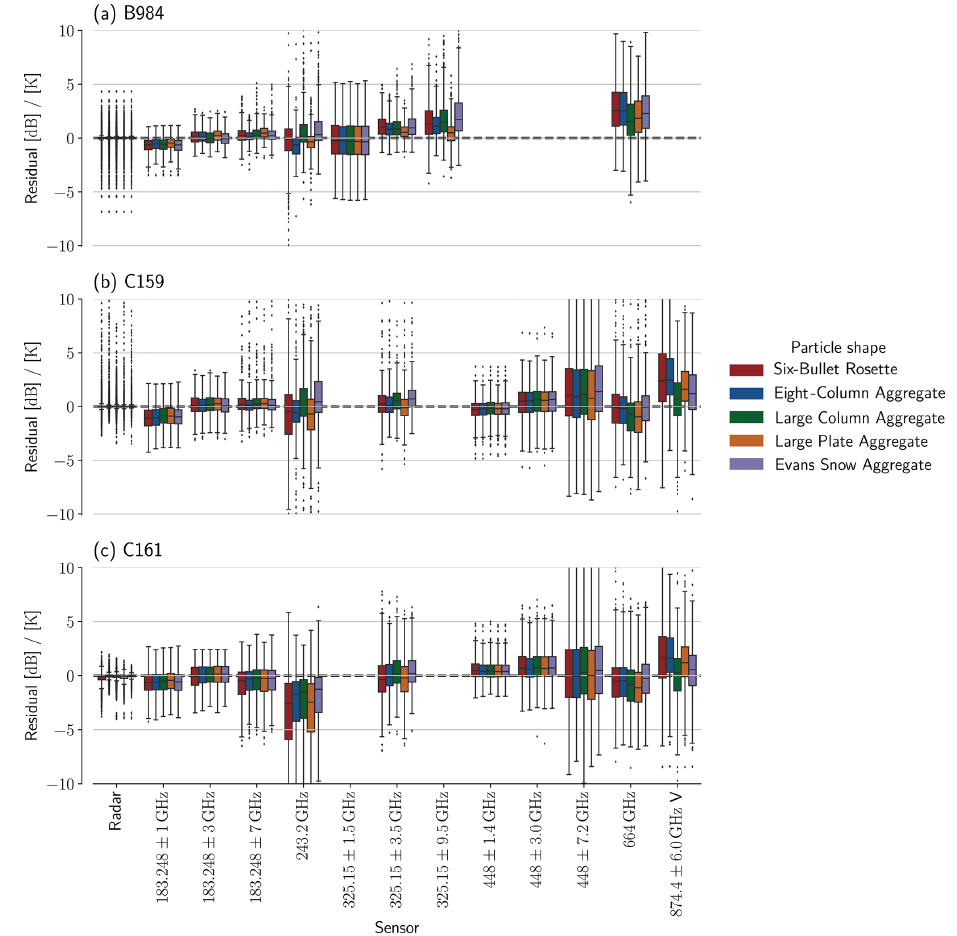
Figure 11. Distributions of retrieval residuals for different particle shapes used in the forward model for each of the three flights.